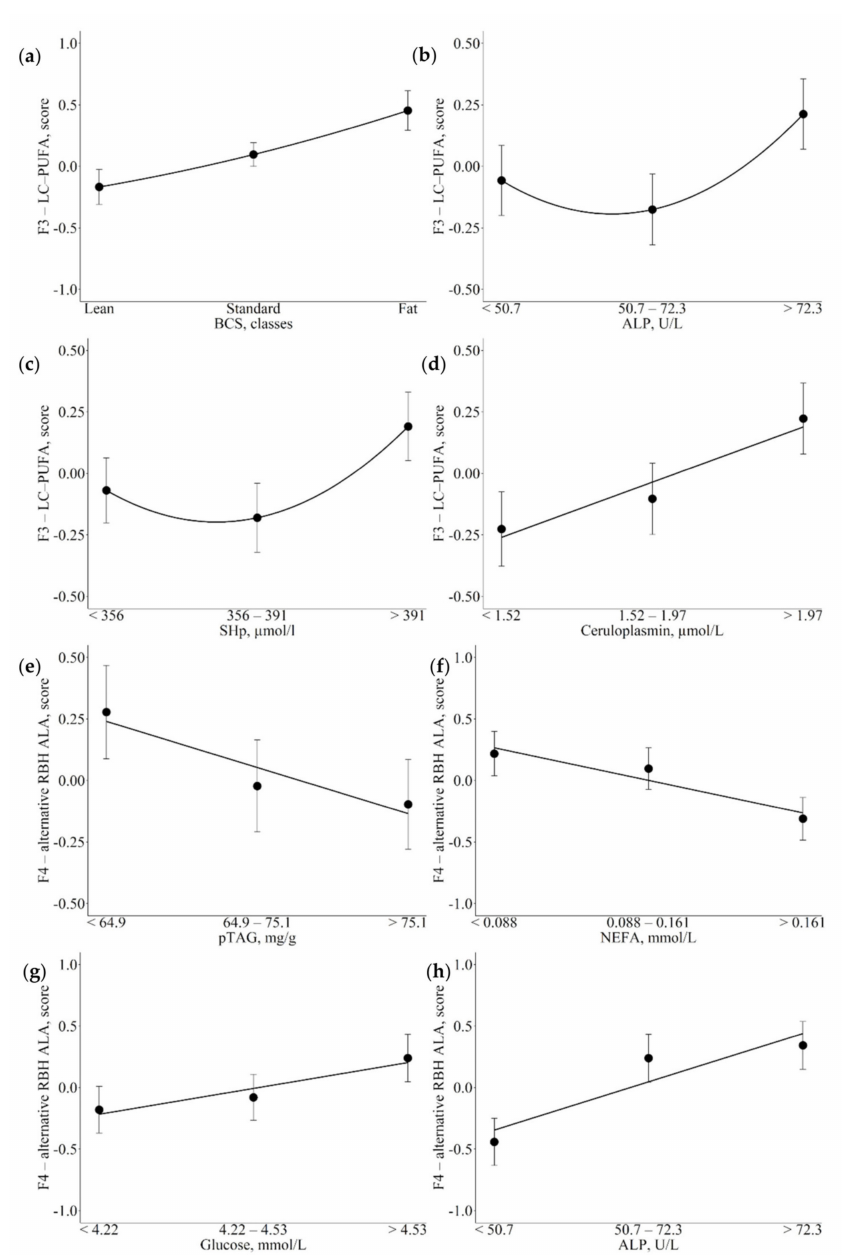
Figure 2. Least square means (LSM) for F3-long chain—polyunsaturated fatty acids (LC-PUFA; ( a – d ) and F4-alternative rumen biohydrogenation of α -linolenic acid (alternative RBH ALA) ( e – h ) across the traits of concern. ( a ): body condition score (BCS); ( b , h ): alkaline phosphatase (ALP); ( c ): total thiol groups (SHp); ( d ): ceruloplasmin; ( e ): predicted liver triacylglycerol (pTAG); ( f ): non-esterified fatty acids (NEFA); ( g ): glucose. Black dots indicate the LSM and error bars indicate the standard error. Trendlines define linear or quadratic pattern according to polynomial contrast calculations ( p <